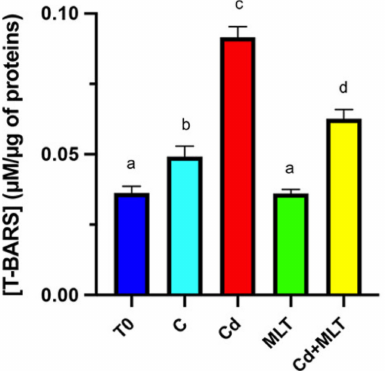
Figure 4. Lipid peroxidation rate evaluated by thiobarbituric acid-reactive species (TBARS) assay of sperm samples incubated with Cd and/or MLT for 24 h. Values are expressed as means ± SEM from 15 samples divided into the 5 groups, including the initial control (T0). a vs. b p < 0.001; a vs. c p < 0.05; a vs. d p < 0.01; b vs. c p < 0.001; c vs. d p <